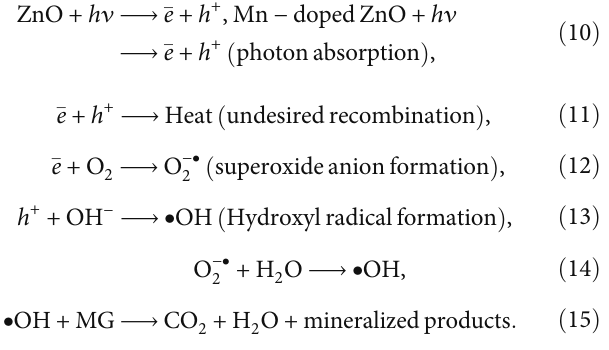
Figure 8: The photodegradation of MG dye mediated by pure and Mn-doped ZnO nanoparticles (a) normalized C ln ð C o / C t Þ , (c) second-order reaction kinetics, and (d) dye degradation (%) as a function of irradiation time,